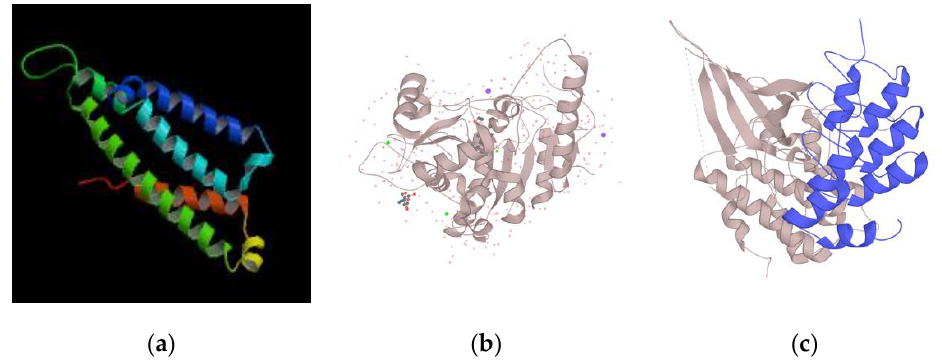
Figure 2. Protein Structure of genes GPR88 , WNT7A , and CDK6 . ( a ) GPR88 protein structure predicted by ModBase. ( b ) The WNT7A protein structure obtained by X-Ray is shown. The image is provided by from Universal Protein Resource Knowledge Base. ( c ) The 3D structure of CDK6 obtained by X-ray, is shown, also provided by UniProt. (UniProtKB) [48].